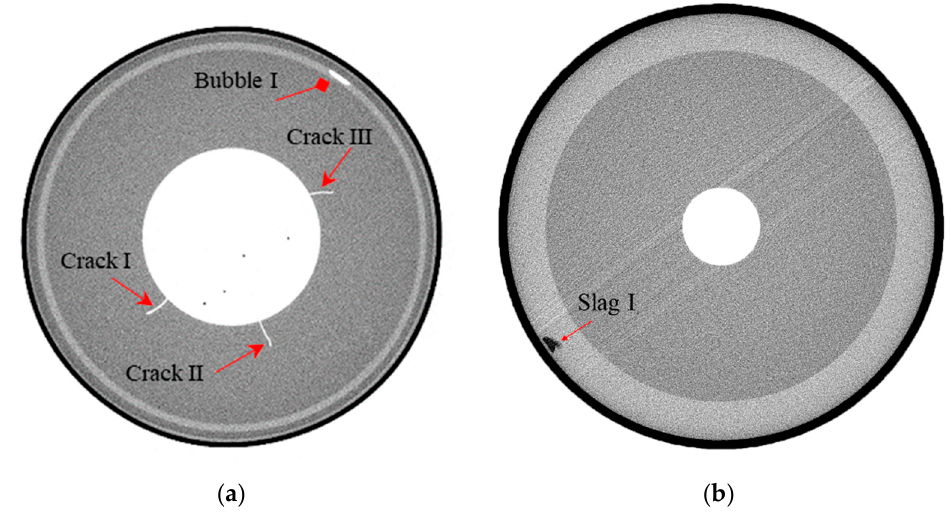
Figure 5. ICT images of propellant defects: ( a ) Image of cracks and bubbles; ( b ) Image of slags.